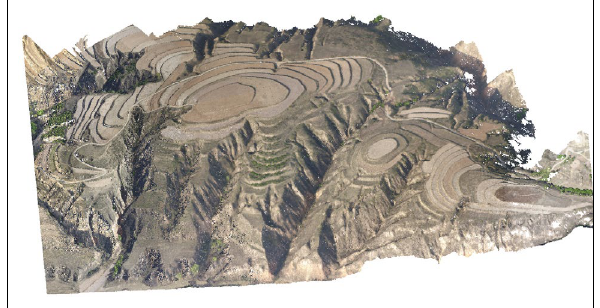
Figure 1. Study Area and Data